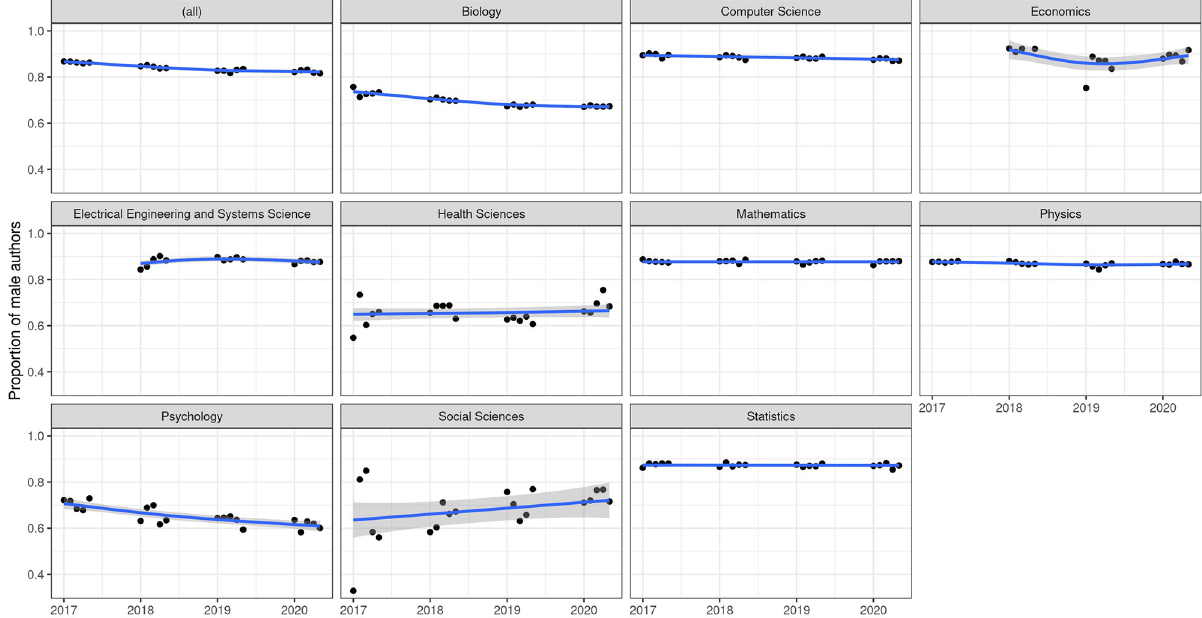
Fig 2. Proportion of male authors per month. The first facet ( all ) shows the global proportion of males per month submitting to all repositories during the period considered. Subsequent facets break down these numbers per